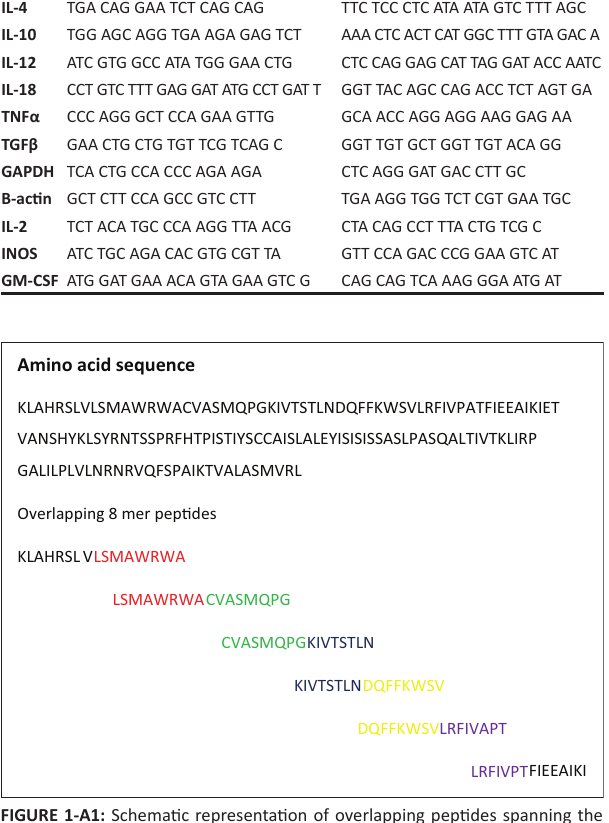
FIGURE 1-A1: Schematic representation of overlapping peptides spanning the length of Erum2510 Fragment 4 used for epitope mapping. Overlapping peptides used in this study were designed in the same format.